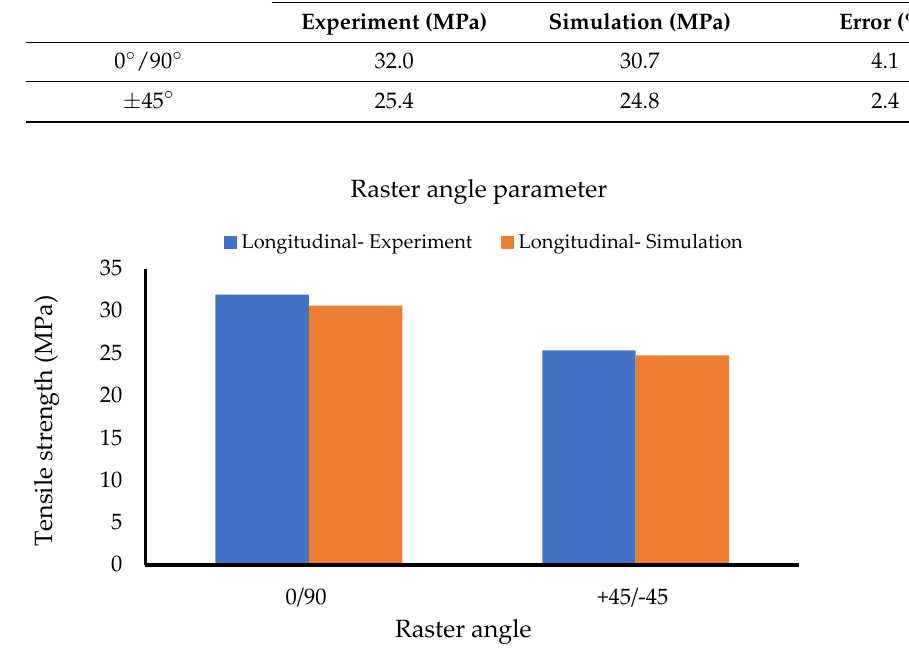
Figure 10. Raster angle set (Method 1).